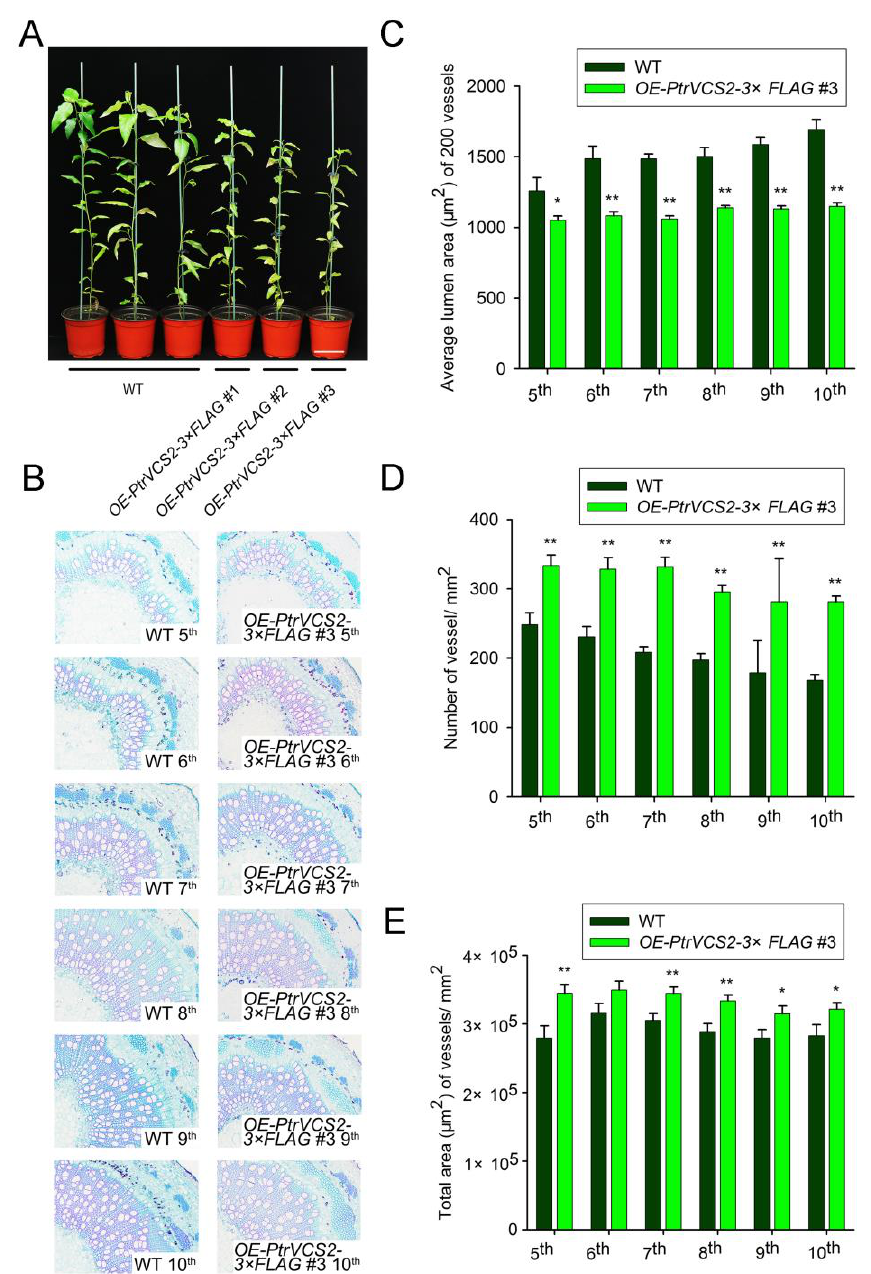
Figure 1. Overexpressing PtrVCS2 gene affects the size and number of vessels in xylem tissue of P. trichocarpa . ( A ) The growth phenotypes of 4-month-old OE - PtrVCS2-3 × FLAG #1, #2, #3 and wild-type (WT) plants. Bars = 10 cm. ( B ) Stem cross-sections of wild-type (WT) and OE-PtrVCS2-3 ×